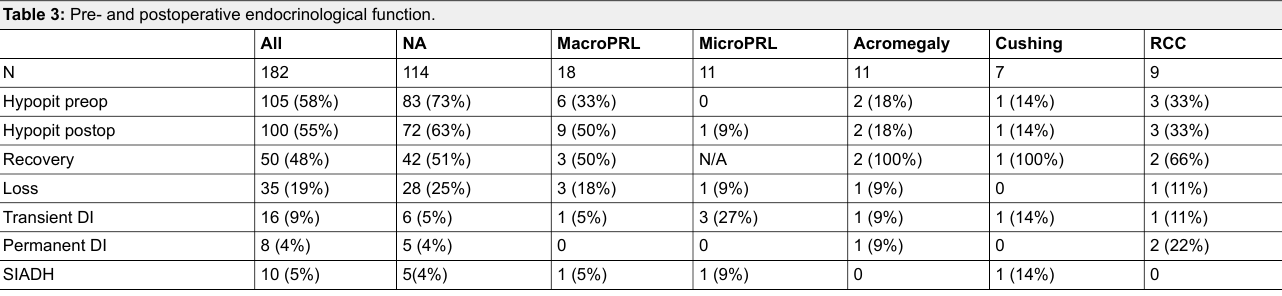
Table 3: Pre- and postoperative endocrinological